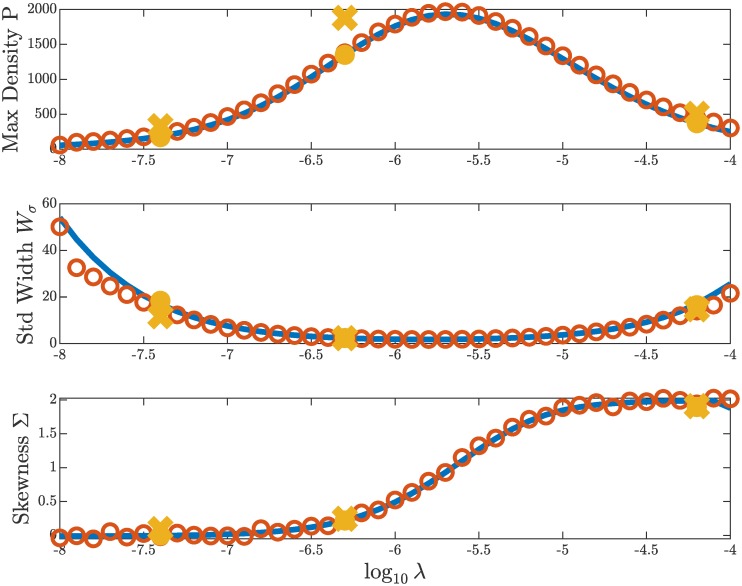
Comparison of the peak, width, and skewness of profiles from the PDE (blue line) and the ABM (orange circle), both obtained through direct numerical simulation for 2 × 105 time steps.Each shape observable is measured from the final numerical output for the PDE and from a time-averaged output the ABM. Longer simulations with 106 time steps, for ABM (gold x) and PDE (gold dot) show little evolution in the profile for longer times. Note that the maximum density is higher for long simulations of the ABM (gold x) because these represent a single instance, rather than an average.